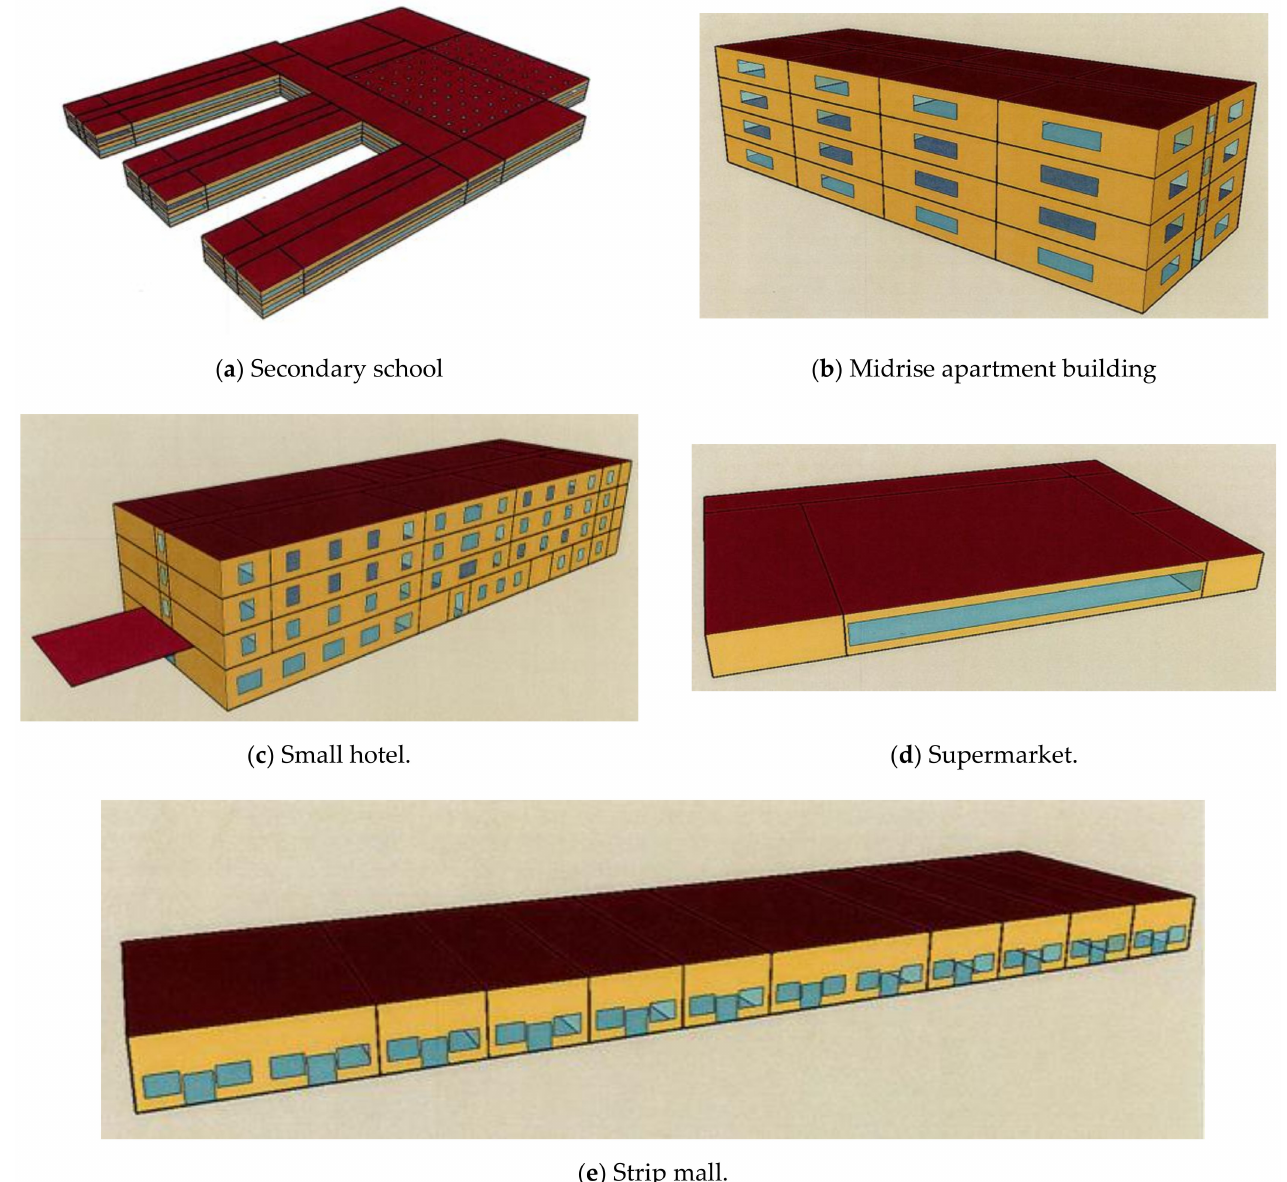
Figure 3. Schematics of reference model buildings used in EnergyPlus simulations (from Thornton et al.